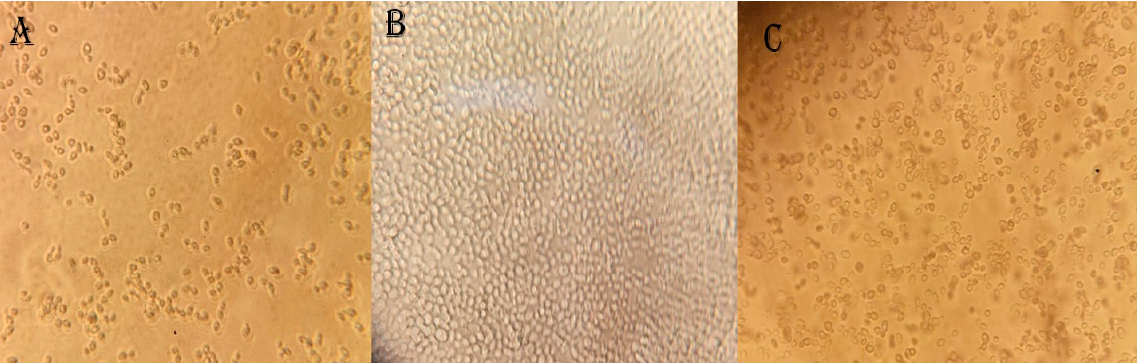
Figure 8. Microscopic examination of the three selected yeast isolates; ( A ): Ap1 isolate, ( B ): B2 isolate, and ( C ): G4 isolate.